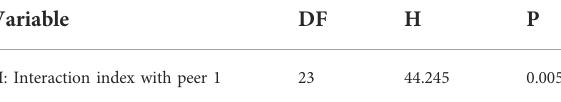
TABLE 2 Summary of Kruskal – Wallis Test for non-parametrical